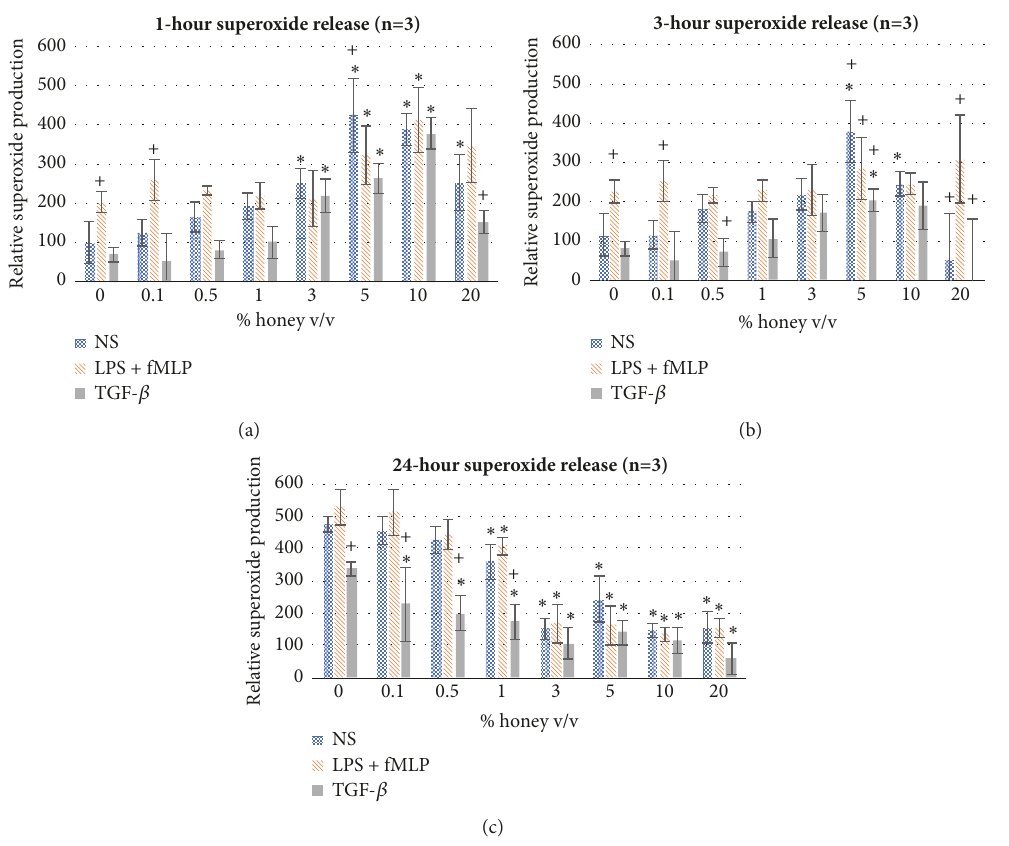
Figure 3: Superoxide production of the NS, LPS + fMLP-stimulated, and TGF- 𝛽 -stimulated dHL-60s cultured at each honey concentration for (a) 1, (b) 3, and (c) 24 hours. Values are shown relative to the 0% honey NS 1-hour value. ∗ indicates statistical significance from the respective 0% honey value of that phenotype, and + indicates statistical significance from the other two phenotypes. 𝛼 =0.05, measured via two-way ANOVA with Holm-Sidak post